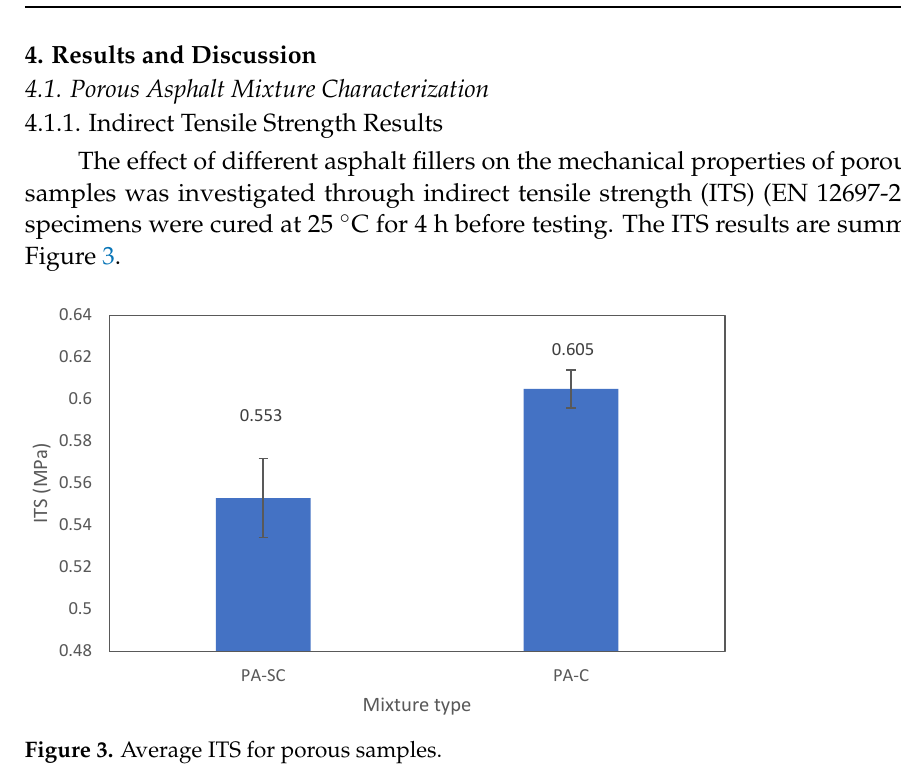
Figure 4. Average ITSR results for porous samples. 4.1.3. Indirect Tensile Stiffness Modulus Results The summary of the average ITSM values is presented in Figure 5 for the porous specimens. The thermal sensitivity of the mixtures was studied by testing three samples